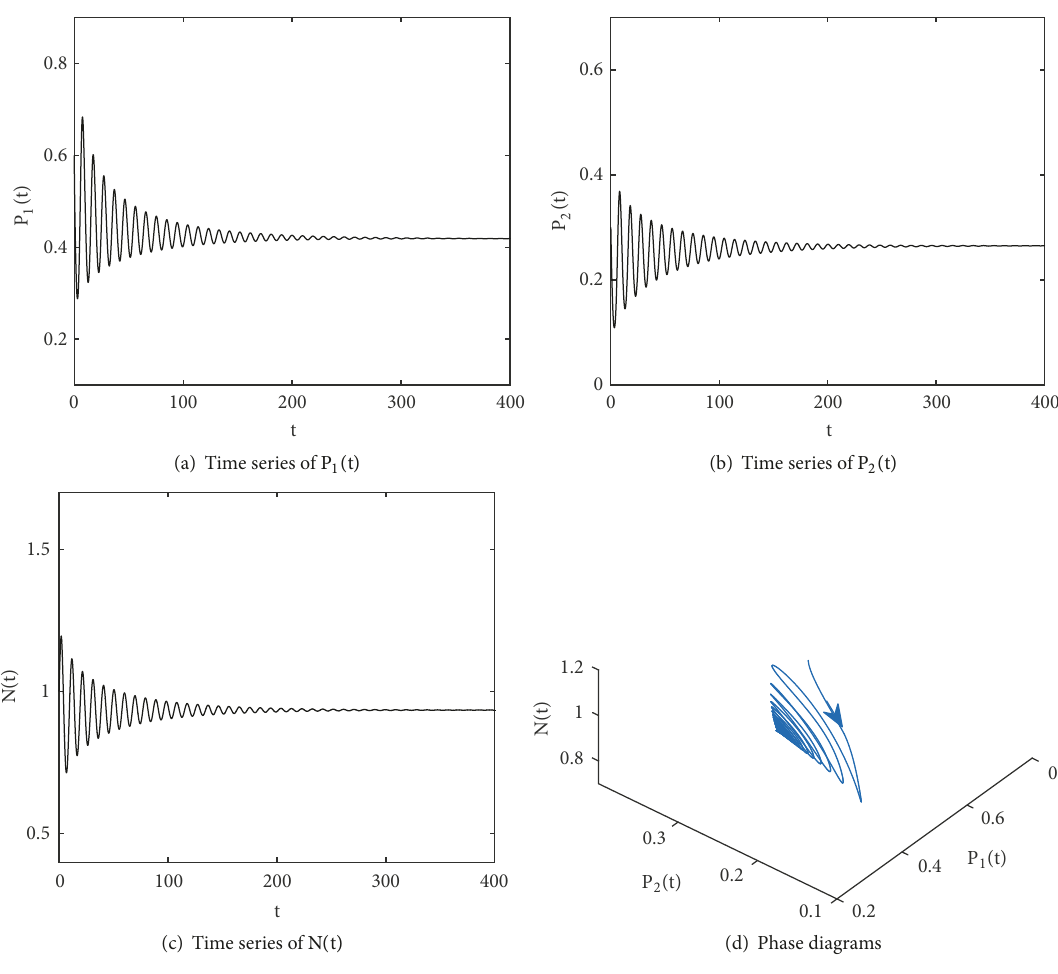
Figure 1: 𝐸 ∗ of system (25) is asymptotically stable when 𝜍 = 1.7 < 𝜍 0